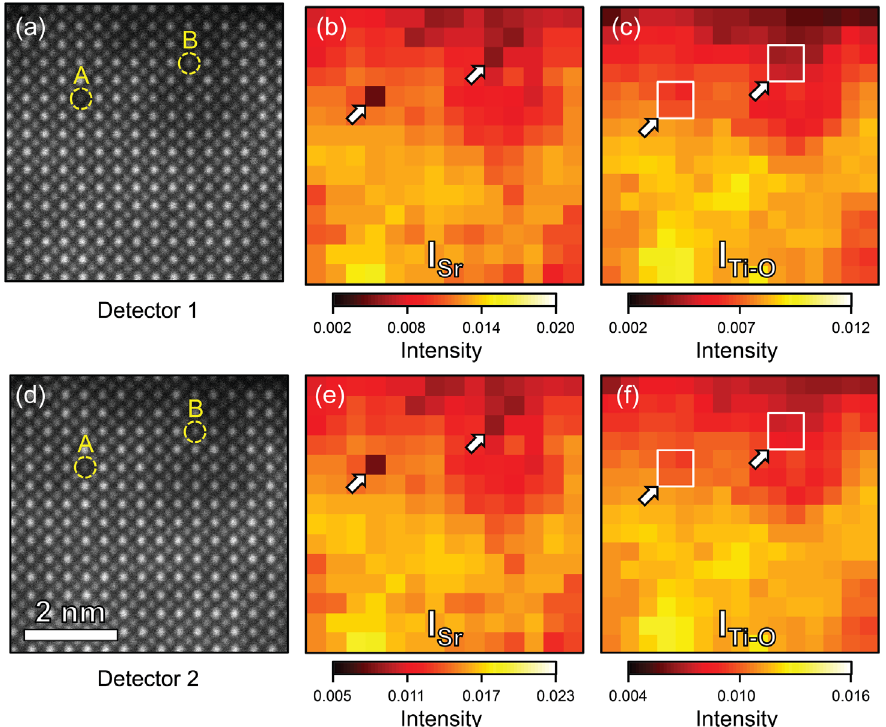
FIG. 1. Quantitative, rigidly registered, variable-angle HAADF-STEM images of Sr vacancies in a SrTiO 3 film grown by MBE. (a,d) HAADF STEM images of the SrTiO 3 film recorded with detectors 1 and 2, respectively. Image intensities are normalized to the incident beam intensity (see scale bars). I and I maps are displayed in (b,e) and (c,f), respectively. The Sr columns containing Sr vacancies Sr Ti-O are labeled A and B and indicated by white arrows in (b) and (e). The four nearest-neighboring Ti-O columns for columns A and B are marked by white boxes in (c) and (f), showing relatively uniform image